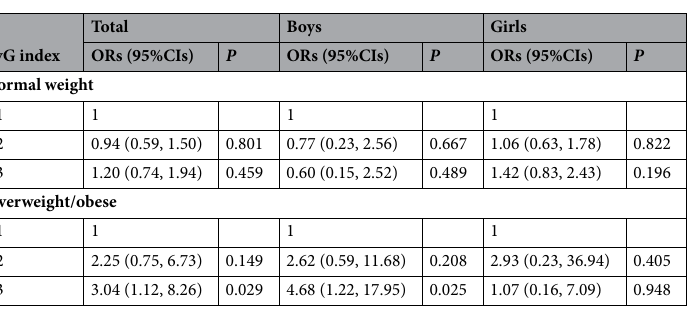
Table 4. Logistic regression analysis of TyG index tertile and low ALM under different body weight States with adjustment for age. ALM appendicular lean mass, TyG index triglyceride-glucose